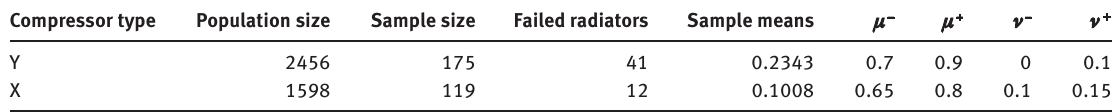
Table 4: IVIF Failure Data Regarding Two Types of Radiators (Finite Populations). Compressor type